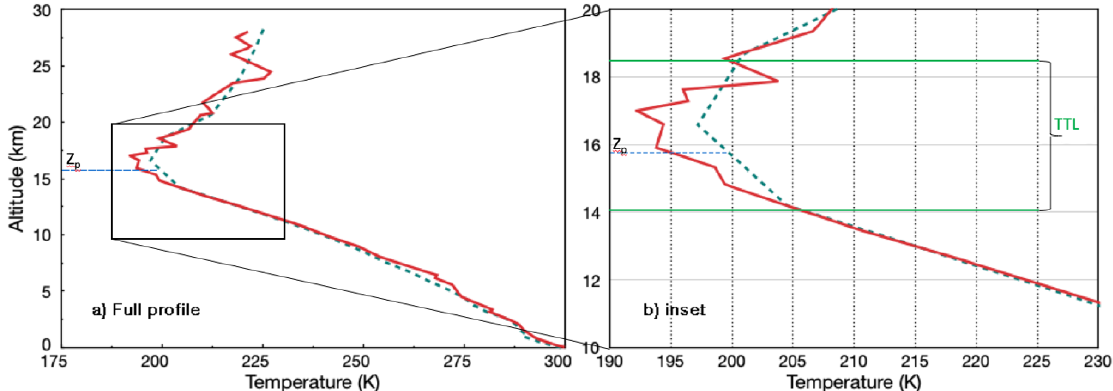
Figure 17. Temperature profiles near Fernando de Noronha, Brazil, 12 UTC, 15 July 2022 at 3.85°S, 32.41°W. ( a ) full profile to 28 km, ( b ) closeup of profile between 10 and 20 km. Thick dashed blue line is from G541 used by CERES and the solid red line is from a radiosonde. Z p and the thin dashed line mark the tropopause height from G541. Approximate boundaries of the tropical tropopause layer shown as green lines.